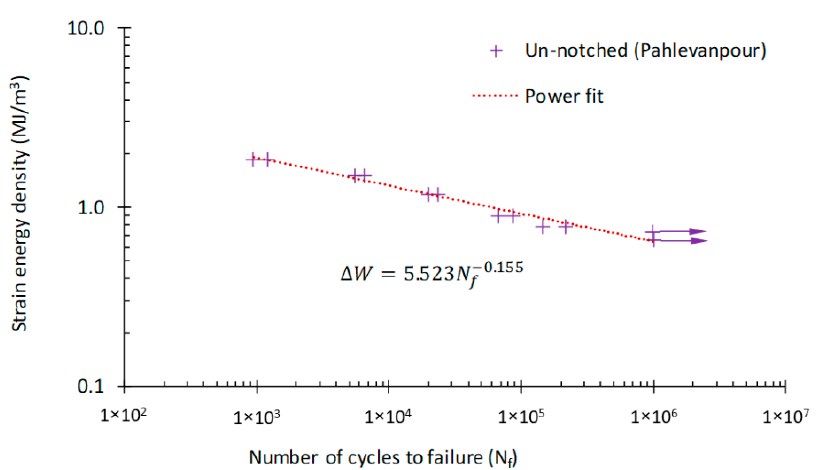
Figure 11. Energy–life curve for unnotched specimens [34]. Reproduced from [34], with permission from Elsevier, 2020.